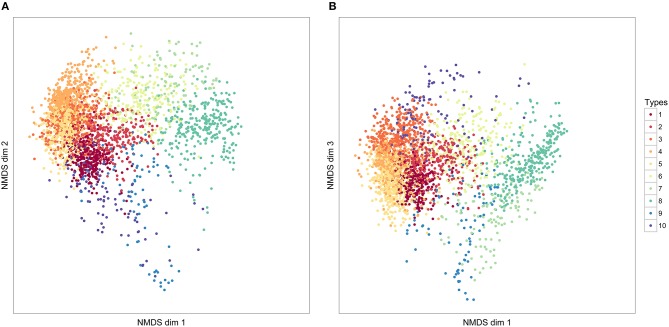
The distribution of 10 element clusters across three NMDS dimensions. Each point represents an individual element. The closer elements are to each other in these dimensions, the more similar they have been judged in similarity, according to our DTW comparison of elements. The values in NMDS dimensions are not meaningful, and following convention, axes have not been labeled. (A) NMDS dimensions 1 and 2; (B) NMDS dimensions 2 and 3.